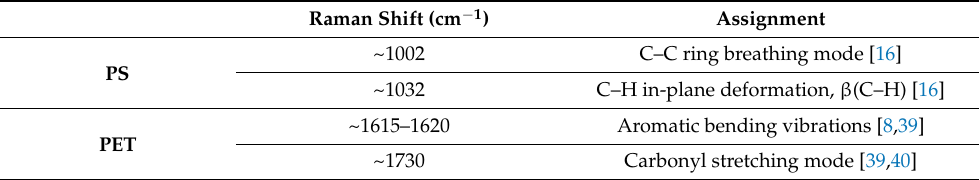
Table A2. Summary of the vibrational band assignments for PS and PET.